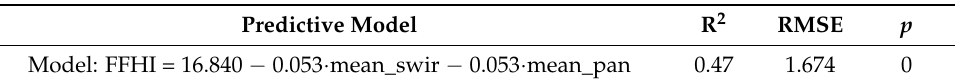
Table 8. Regression model predicting the FFHI derived using all-subsets regression. Predictive